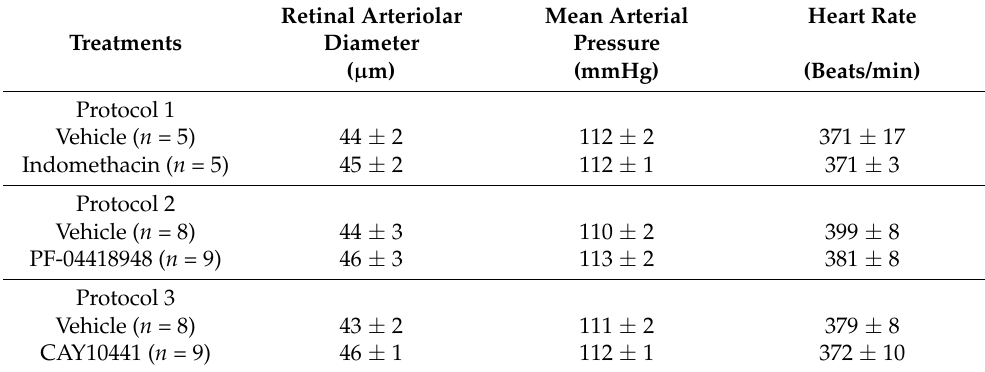
Table 1. The baseline retinal arteriolar diameter, mean arterial pressure, and heart rate values.